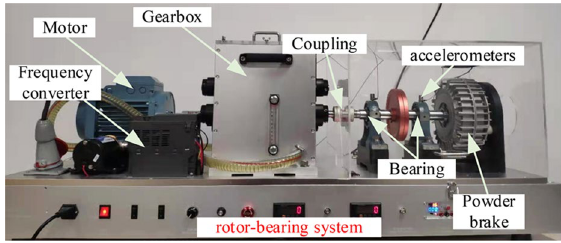
Figure 9. VALENIAN-PT500 The test rig.